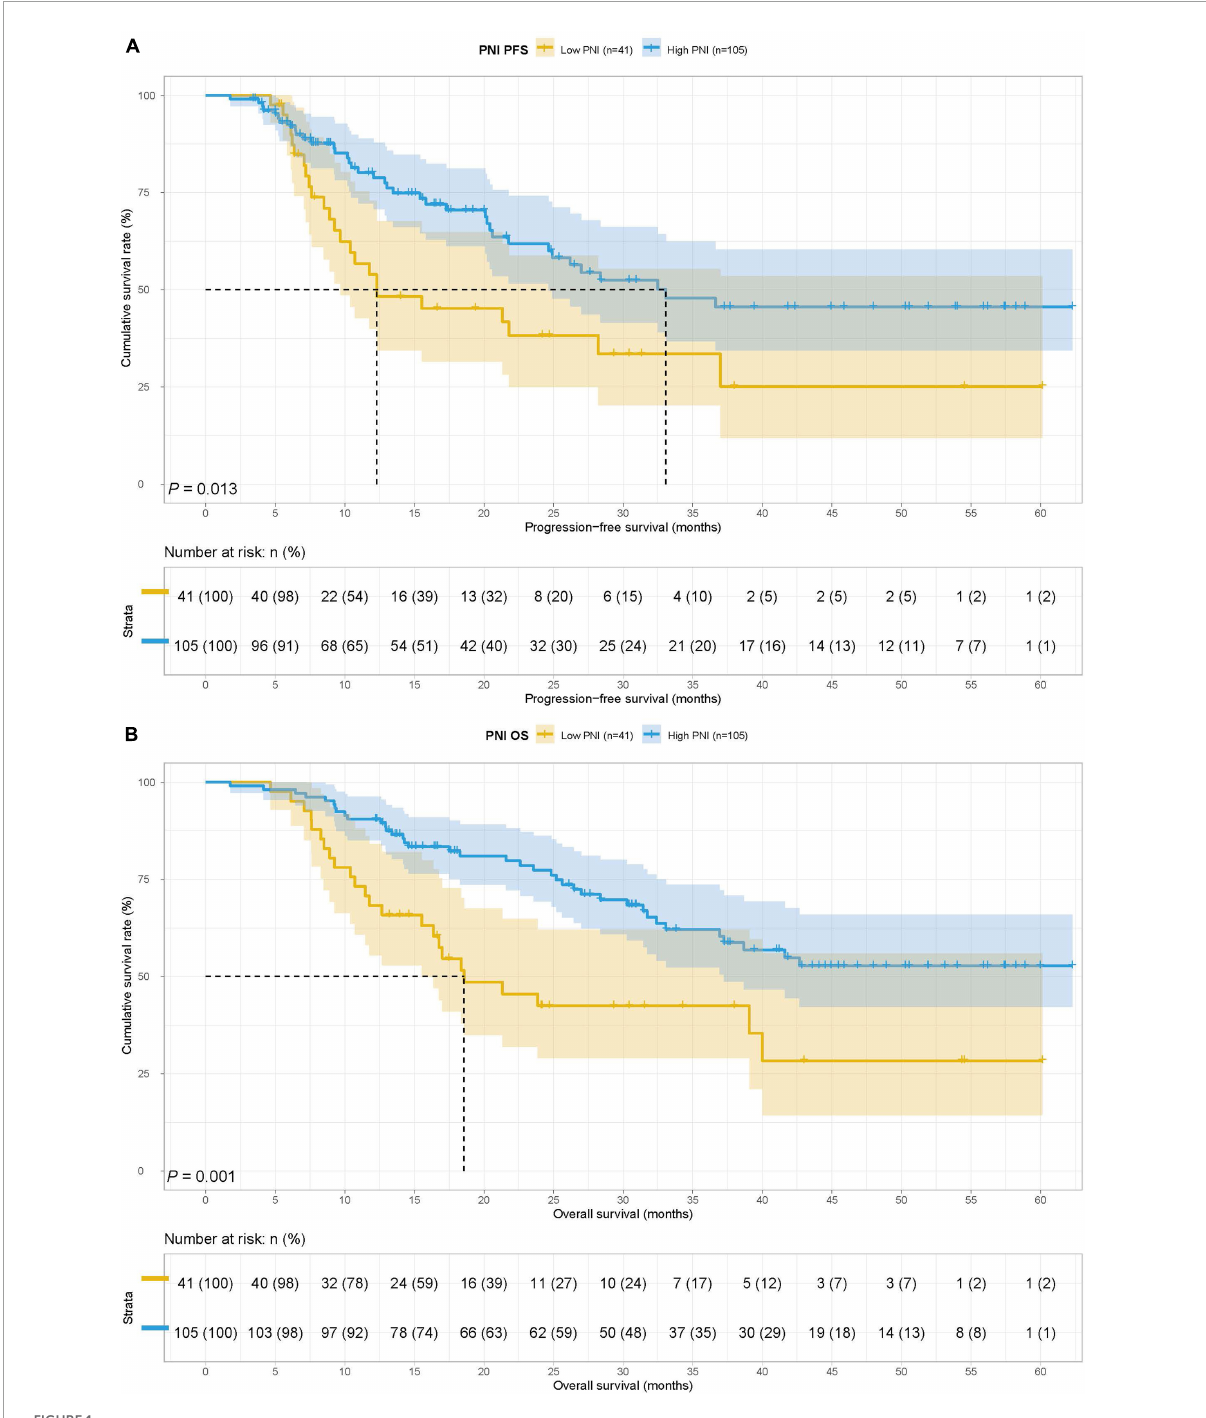
FIGURE1 Prognostic nutrition index (PNI) related survival curve of (A) progression-free survival (PFS) and (B) overall survival (OS) in all patients.